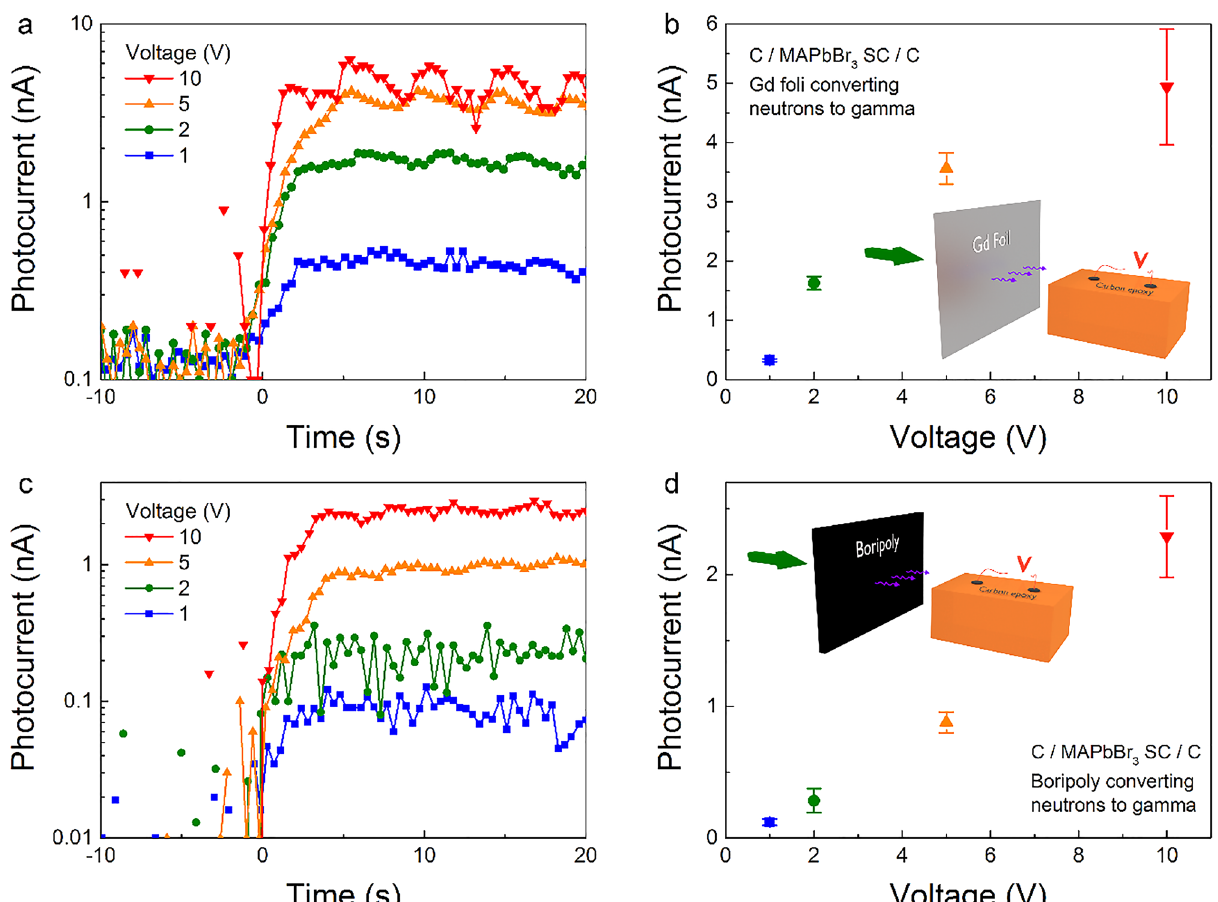
Figure 4. ( a ) Zoom in on the leading edge of the signal and ( b ) its dependence with various bias voltage for the Gd-foil/MAPbBr 3 detector. Distance of crystal to foil is 2.5 cm. ( c ) Zoom in on the leading edge of the signal and ( d ) its dependence with various bias voltage for the Boripoly/MAPbBr 3 detector. Distance of crystal to foil is 0.5 cm. Inset: Setup